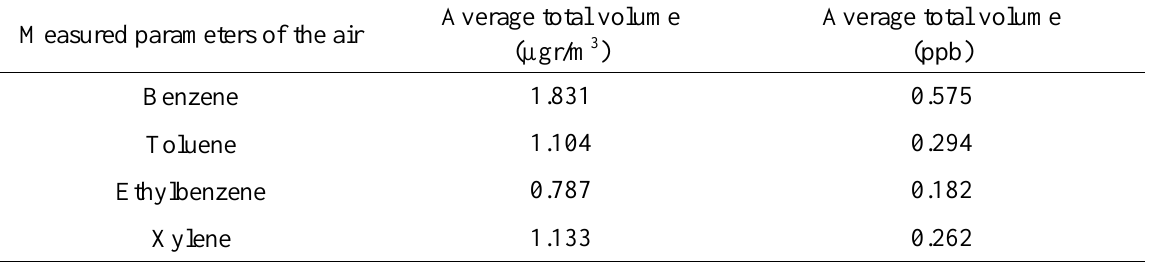
Table 4. Average total volume of measuring the concentration of Bituminous production units Measured parameters of the air